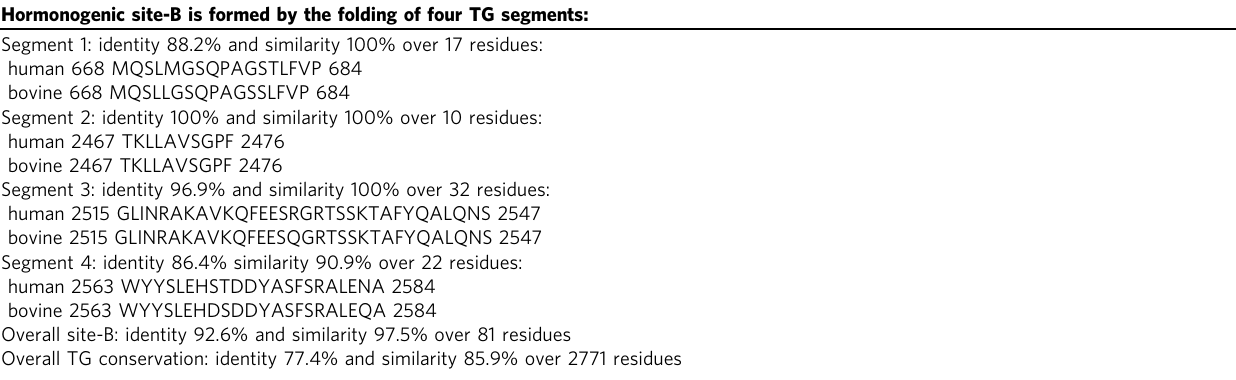
The region is formed by four segments (Segments 1-4) comprising a total of 81 amino acid residues. Conservation was measured on the MBOSS-matcher using a BLOSUM62 evolution